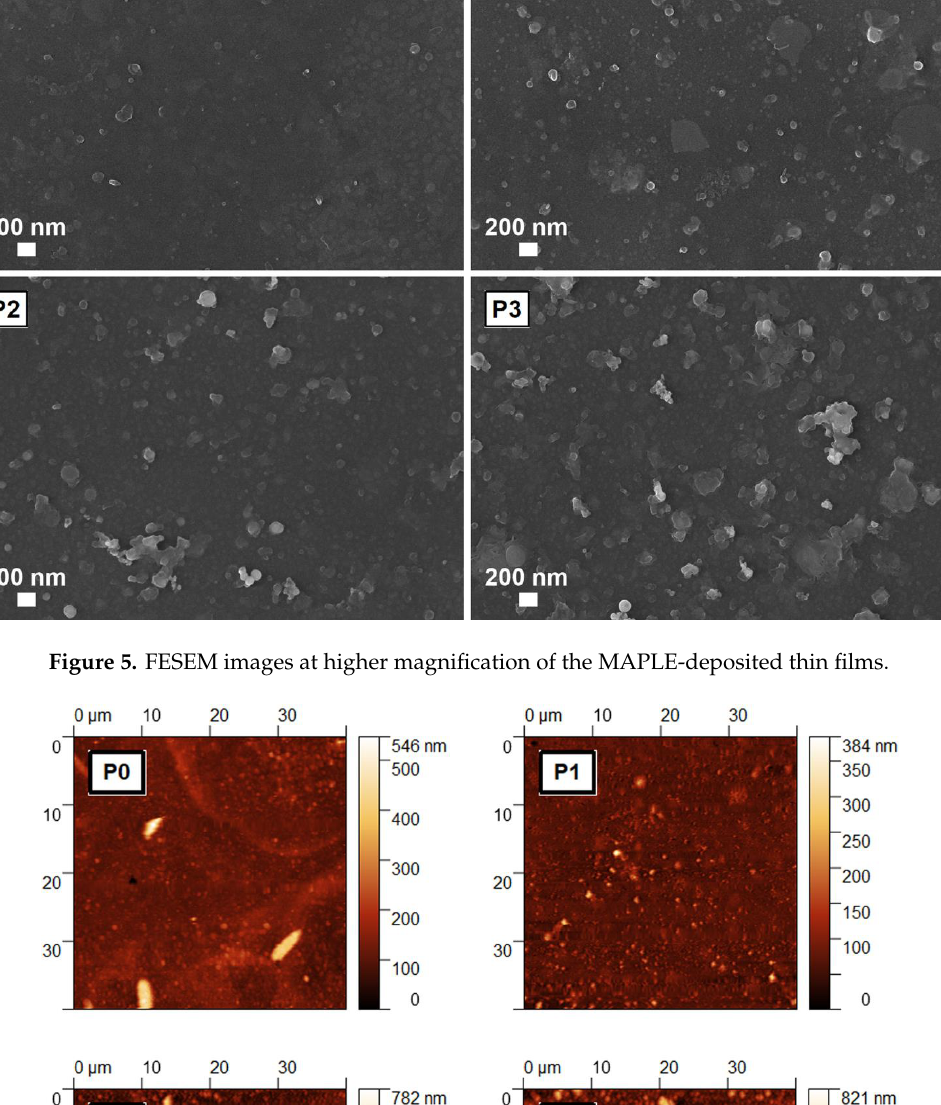
Figure 4. FESEM images of the MAPLE-deposited thin films. Insets: energy-dispersive X-ray analysis (EDX) spectra and weight and atomic percentages of the elements in the corresponding samples.